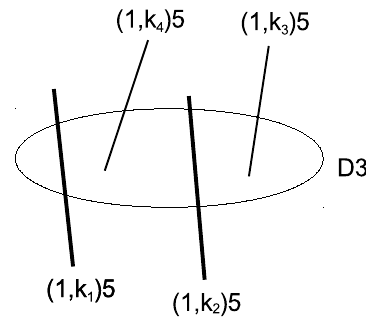
Figure 1 . The brane con(cid:12)guration which gives a Chern-Simons-matter theory with n =